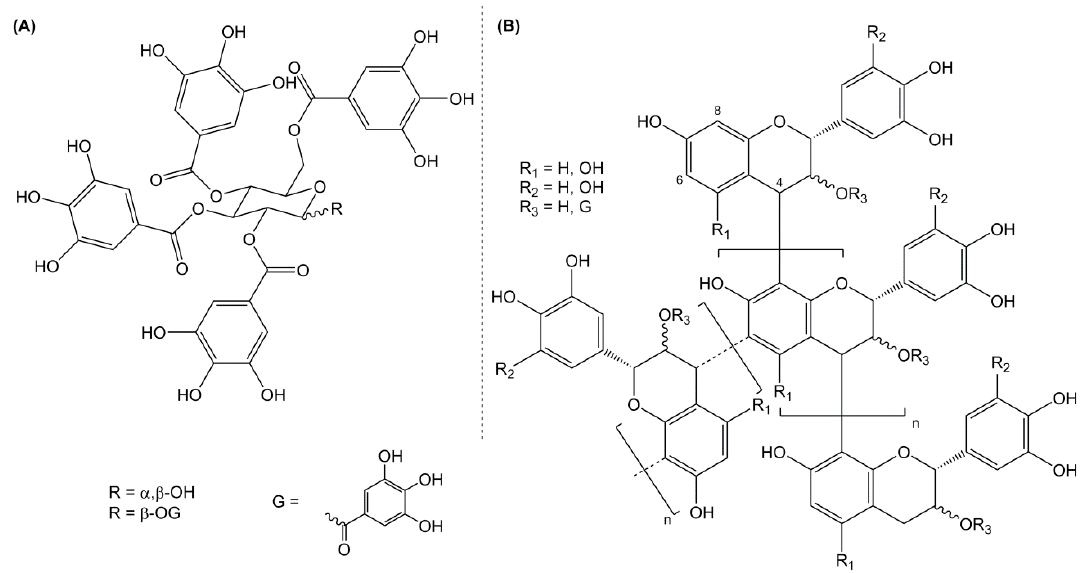
Figure 7. Main structures of tannins from vascular plants: hydrolysable tannins ( A ) and condensed tannins ( B ).